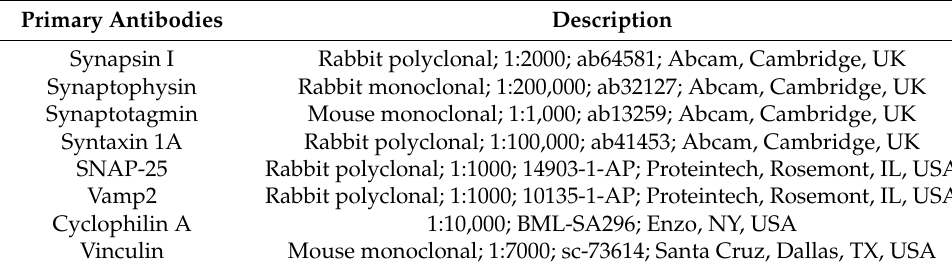
Table 2. Primary antibodies used for Western